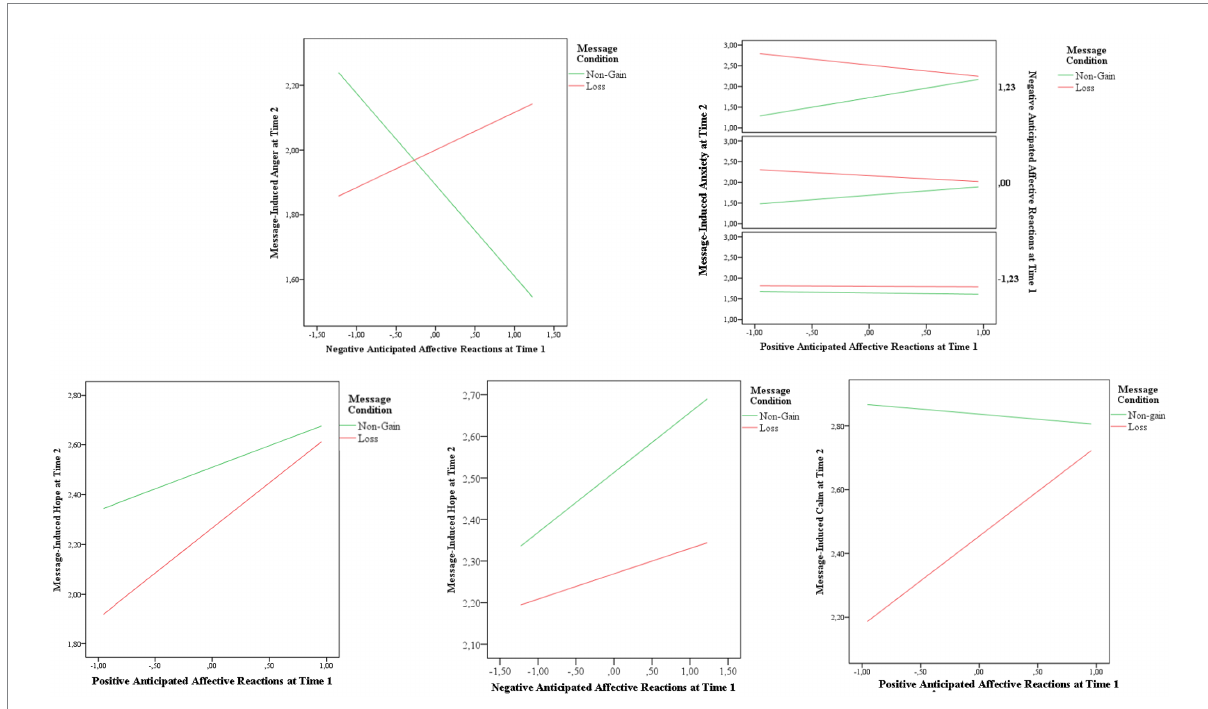
FIGURE 3 Message-induced emotions at time 2 in non-gain and loss message conditions at different levels of positive and negative anticipated affective